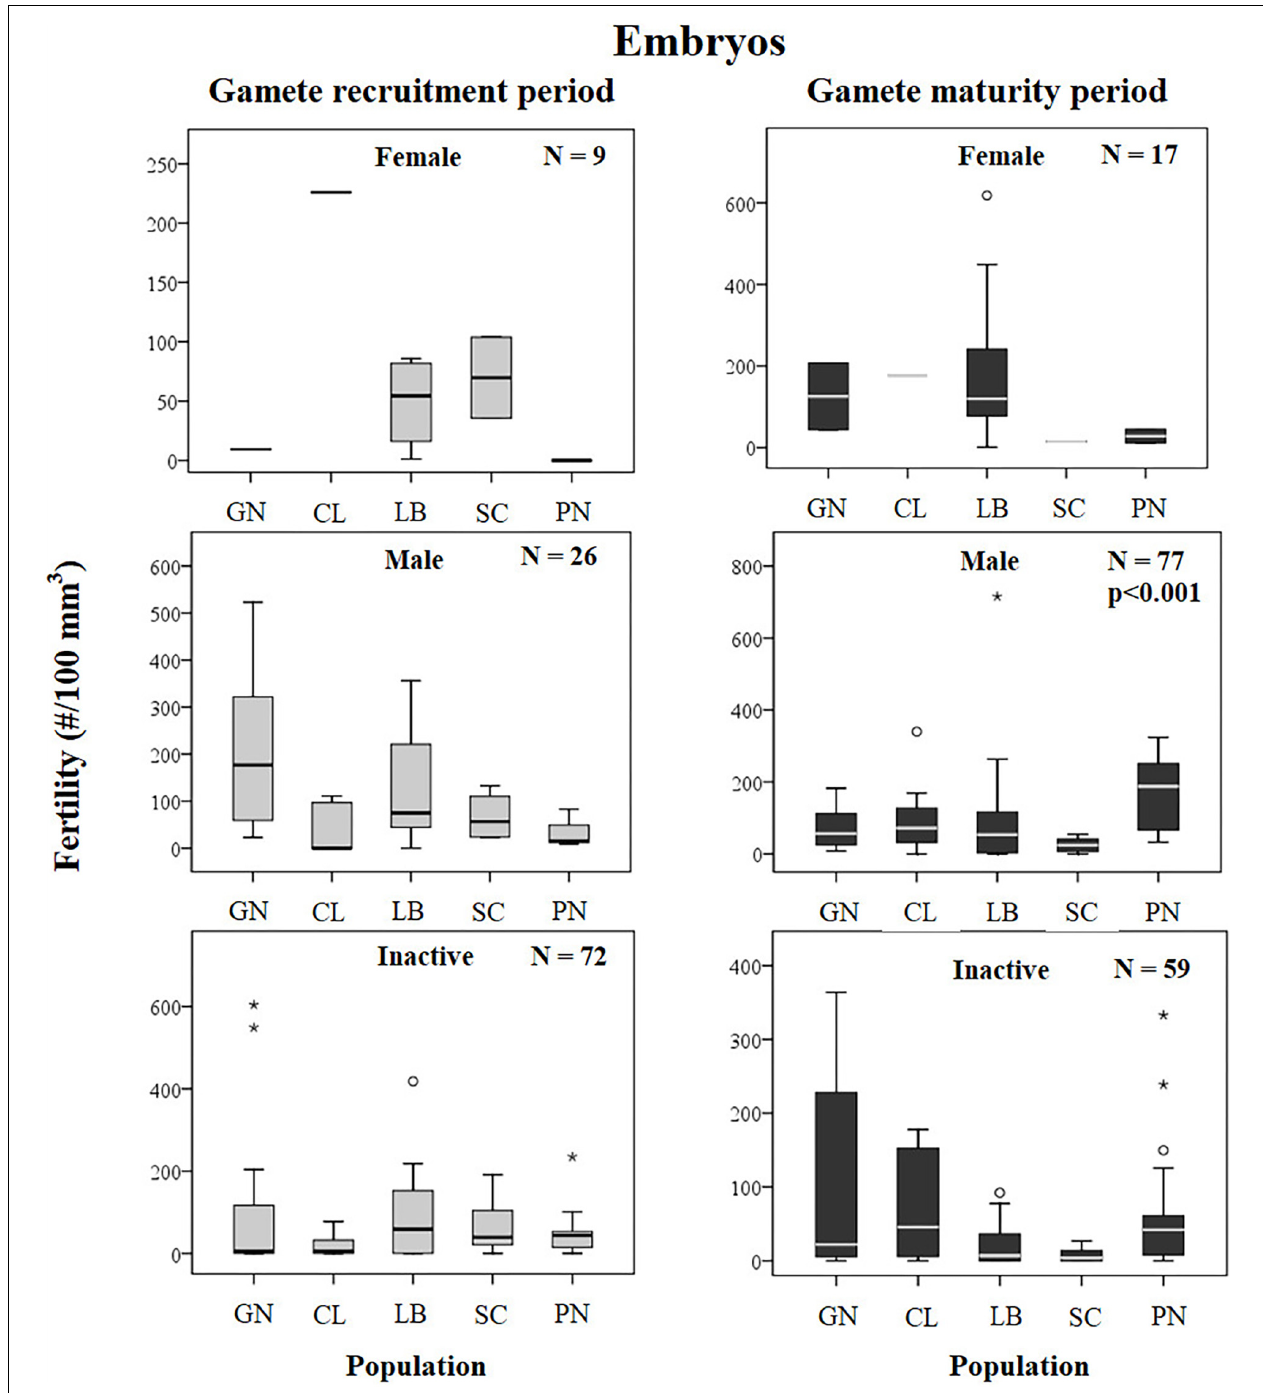
FIGURE 9 | Embryos. Boxplots of reproductive parameters per study site (GN Genova; CL Calafuria; LB Elba Island; SC Scilla; PN Pantelleria Island) during the gamete recruitment and gamete maturity periods. Each boxplot diagram shows the median (solid horizontal line), the first and third quartiles (box outline), the minimum and maximum values (whiskers) and the outliers (stars and circles). N , number of polyps; p , significance of the ANOVA/Kruskal–Wallis